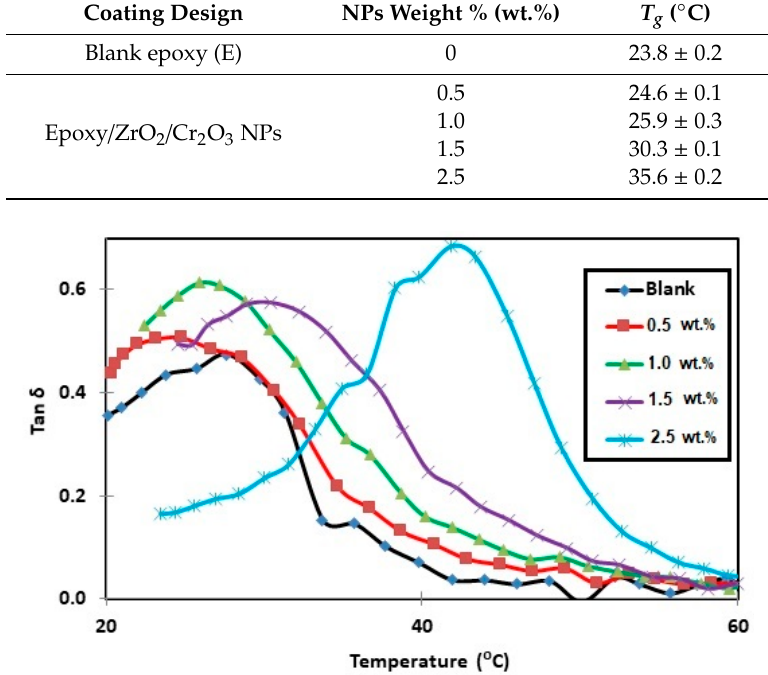
Figure 7. Effect of NPs loading on loss tangent (tan δ ) of epoxy